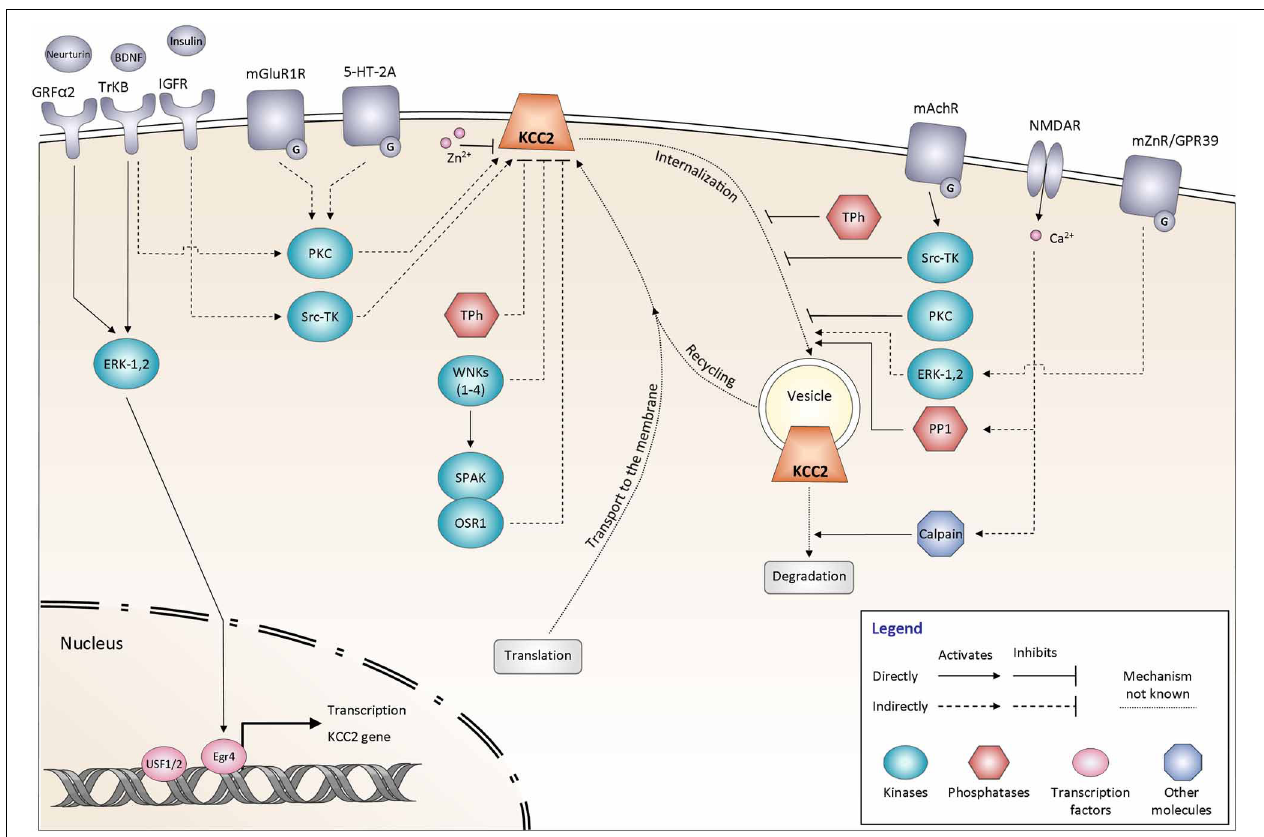
FIGURE 3 | Signaling pathways controlling KCC2 function. The regulation of KCC2 activity is mediated by many proteins including kinases and phosphatases. It affects either the steady state protein expression at the plasma membrane or the KCC2 protein recycling. All the different pathways are explained and discussed in the main text. The schematic drawings of KCC2 as well as other membrane molecules do not reflect their oligomeric structure. GRF α 2, GDNF family receptor α 2 ; BDNF, Brain-derived neurotrophic factor ; TrKB, Tropomyosin receptor kinase B ; Insulin, Insulin-like growth factor 1 (IGF-1) ; IGFR, Insulin-like growth factor 1 receptor ; mGluR1, Group I metabotropic